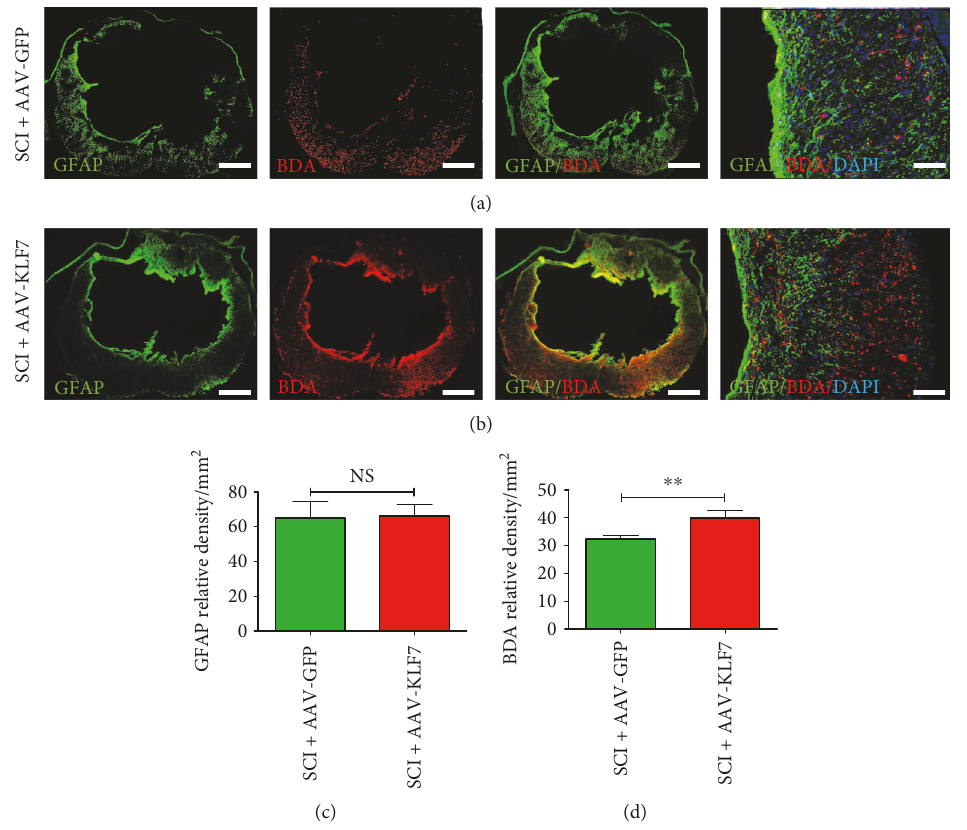
Figure 9: AAV-KLF7 signi fi cantly improves DPSN axonal plasticity around the lesion. Five weeks following contusion injury, (a-b) representative immunohistochemical stainings for GFAP (green) and BDA (labeling DPSN axons, red) and nuclear staining (DAPI, blue) surrounding the epicenter of SCI+ AAV-GFP and SCI+ AAV-KLF7 groups are presented. Quantitative analyses of the GFAP relative density (c) and BDA relative density (d) around the lesion area. n = 6 mice/group. Student ’ s t -tests; green indicates SCI +AAV- GFP control; red indicates SCI +AAV-KLF7. ∗∗ P < 0 01 . NS: not signi fi cant. Scale bars: 300 μ m or 100 μ